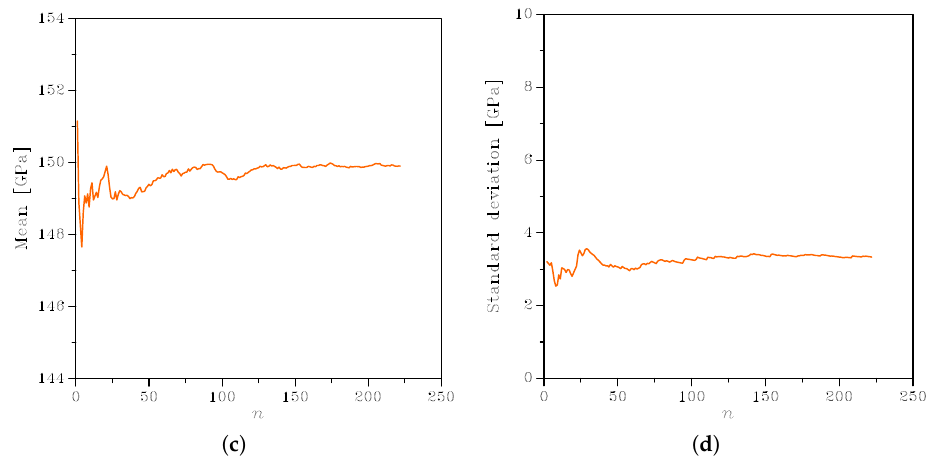
Figure 7. Effect of the number n of samples in the Monte Carlo analysis on the convergence of the ( a , c ) mean value and ( b , d ) standard deviation of in-plane Young’s modulus E , for uniform strain BCs.